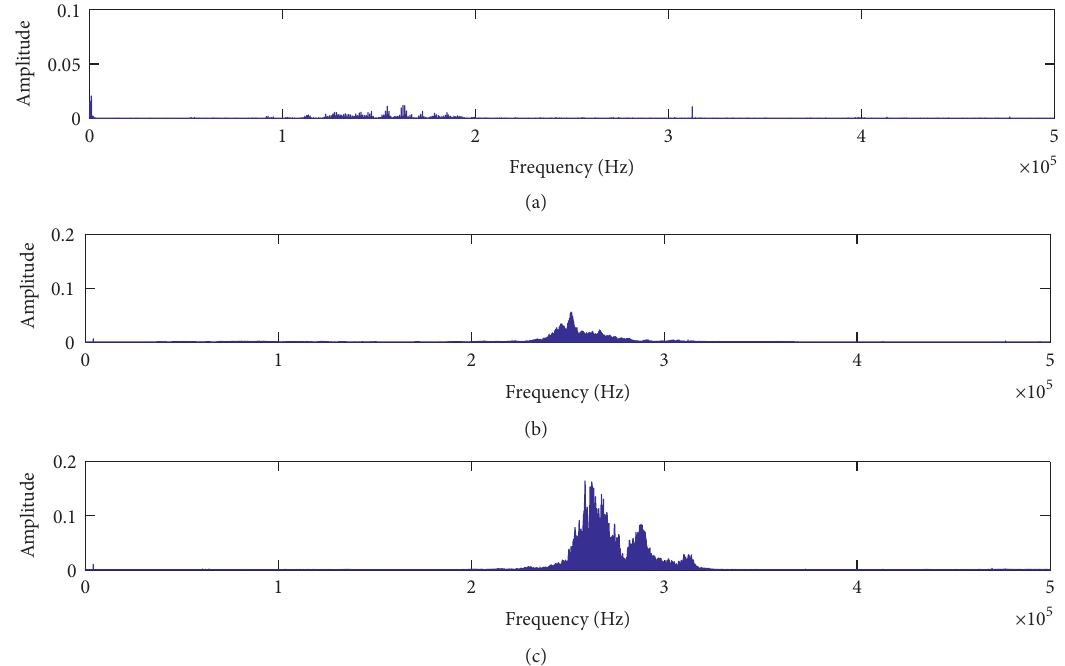
Figure 4: The FFTof AE signal by discharge in different working mediums: (a) for discharge in air; (b) for discharge in kerosene; and (c) for discharge in water-based emulsion. Acoustic emission analysis in different working